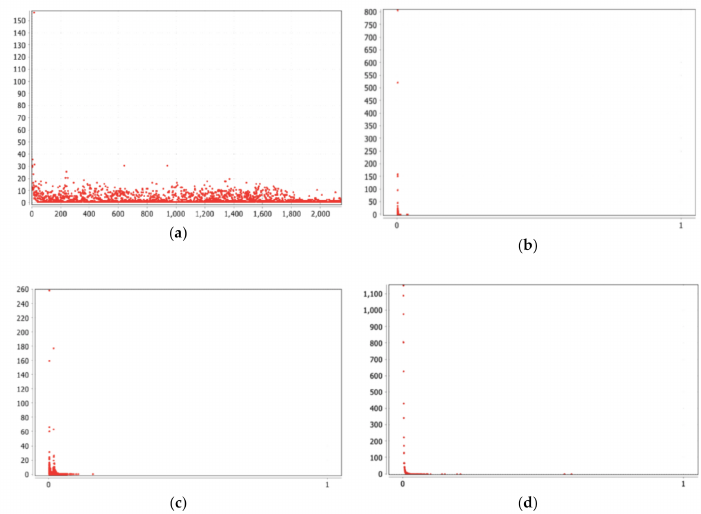
Figure 2. ( a ) Modularity distribution of communities; ( b ) PR and relevance nodes analysis; ( c ) Hubs distribution; ( d ) Hyperlink-Induced Topic Search (HITS) authority analysis (Source: The